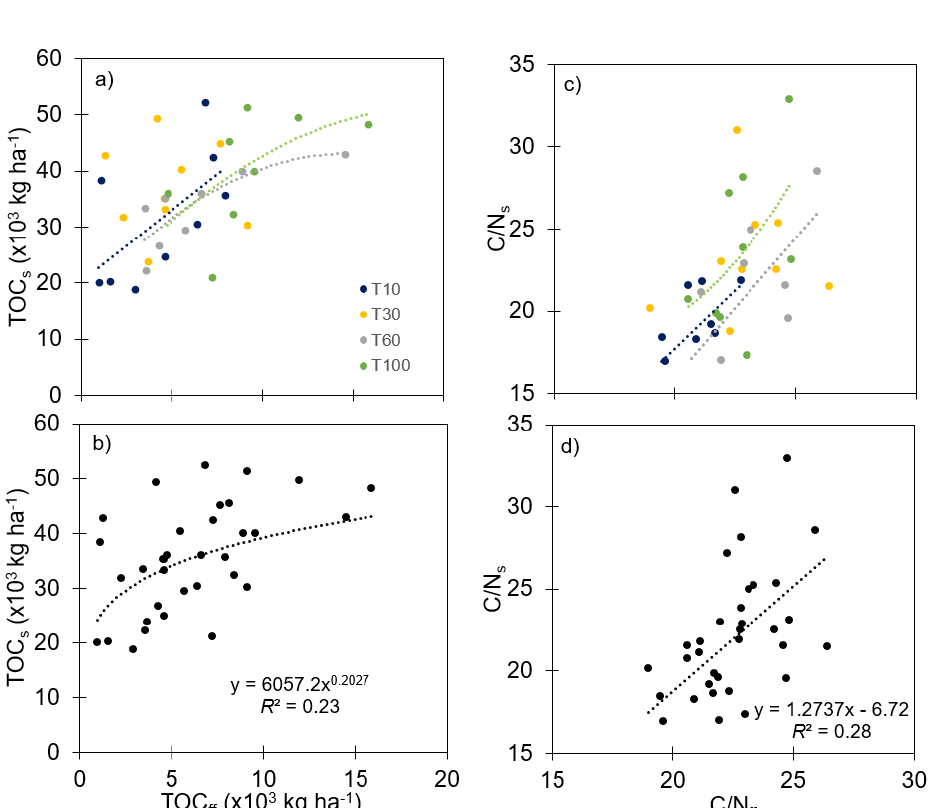
Figure 3. Total organic carbon in soil (TOC s ) as a function of total organic carbon in forest floor (TOC ff ) ( a , b ). C/N in soil (C/Ns) as a function of C/N in forest floor (C/N ff ) ( c , d ).